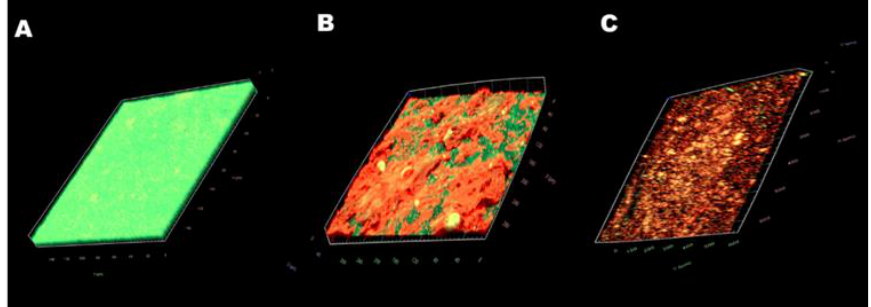
Figure 6. CLSM images of S. aureus biofilm formations on medical-grade silicone surfaces without treatment ( A ) and with CA ( B ) and CSNP-CA treatments ( C ). Biofilms were stained with the Live/Dead ® BacLight™ Bacterial Viability and Counting Kit. CLSM reconstructions show the three- dimensional staining patterns for live cells (SYTO-9, green) and dead cells (propidium iodide, red). Magnification, ×10.